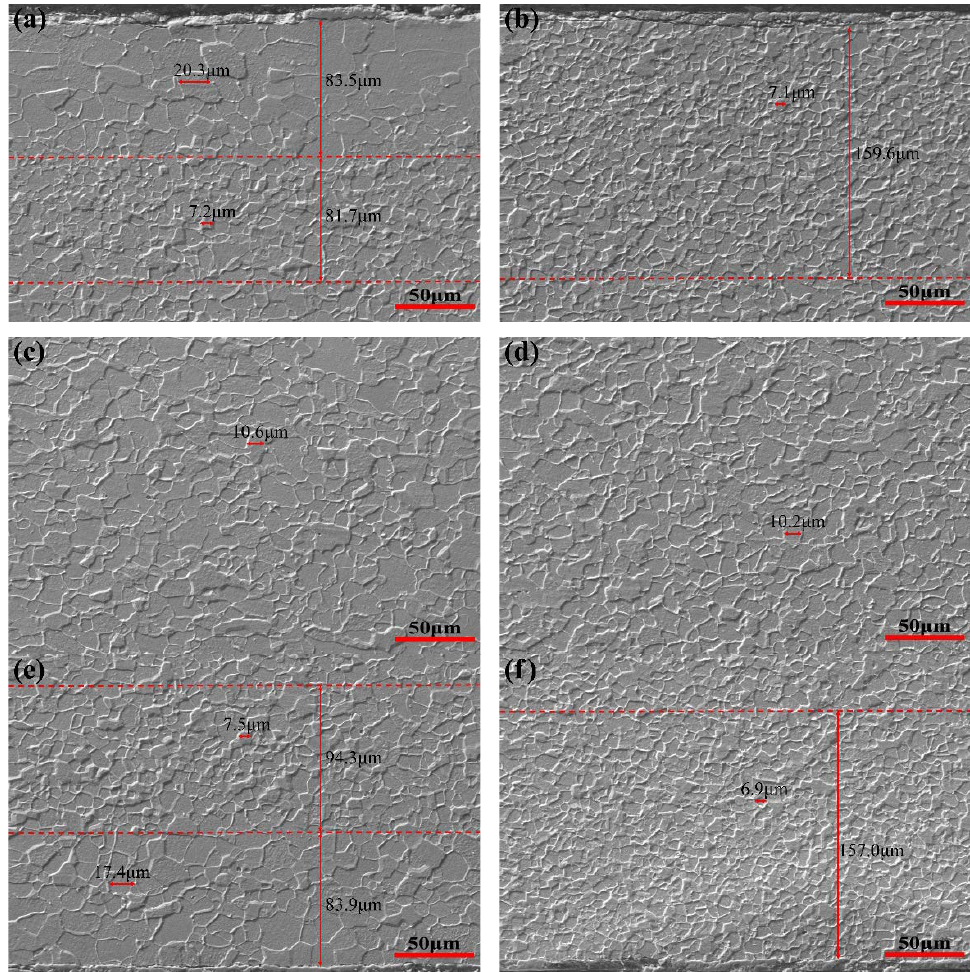
Figure 3. SEM microstructure of different C content for 1.0 mm thickness. ( a ) The upper surface of ELC; ( b ) the upper surface of LC; ( c ) the central thickness of ELC; ( d ) the central thickness of LC; ( e ) the lower surface of ELC; ( f ) the lower surface of LC. Here, Ñ (A) is the relative quantity of component A, x a , x b and x p are the fraction